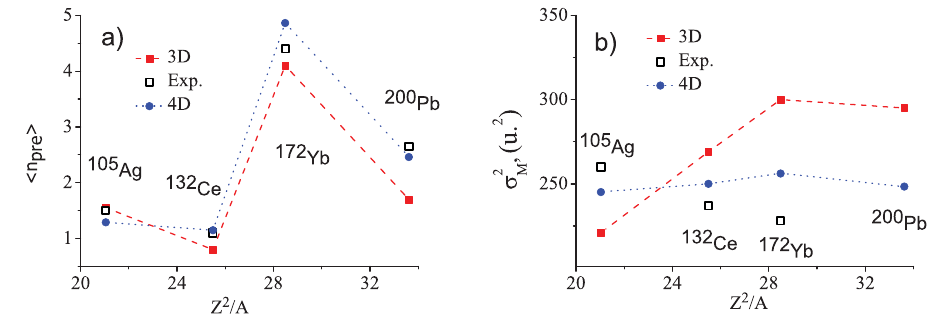
Figure 4. The prescission neutron multiplicity (a) and variance of fission fragment mass distribution (b) obtained for the different nuclei. The open symbols are experimental data, the filled circles are results of 4D calculations with different k s values (see text for details) and (cid:1) K = 0.077 (MeVzs) − 1 / 2 , the filled squares are results of corresponding 3D